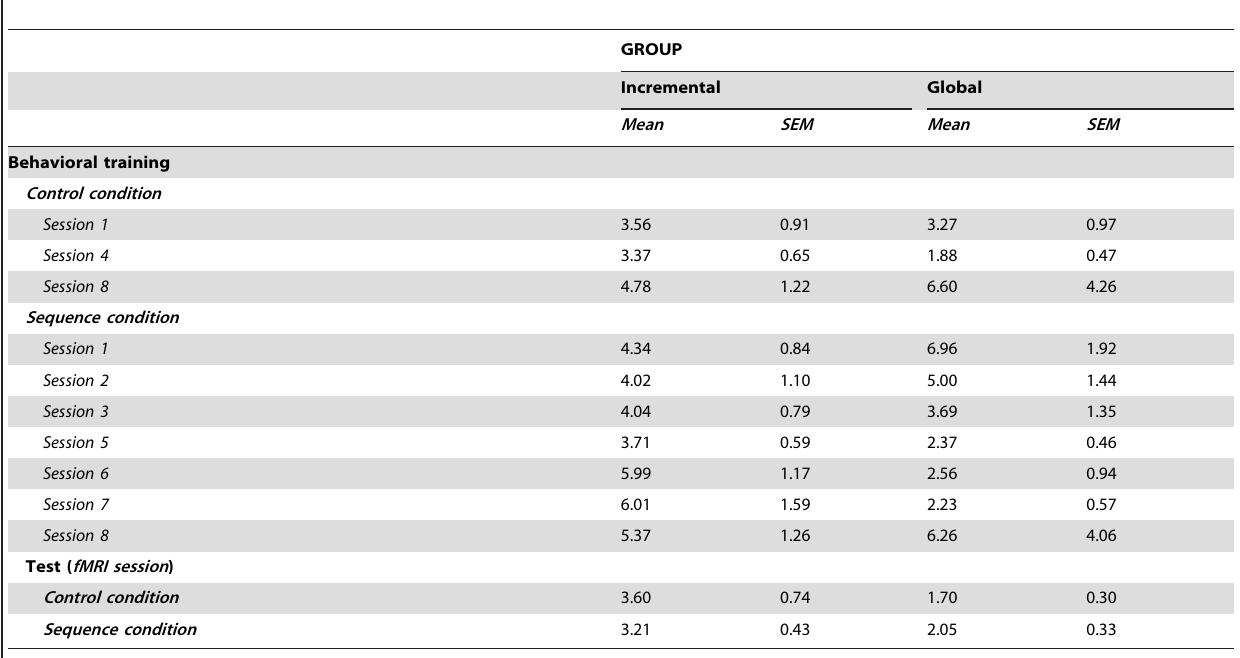
Table 1. Error rates (percentages) across sessions, type of block, experimental condition and